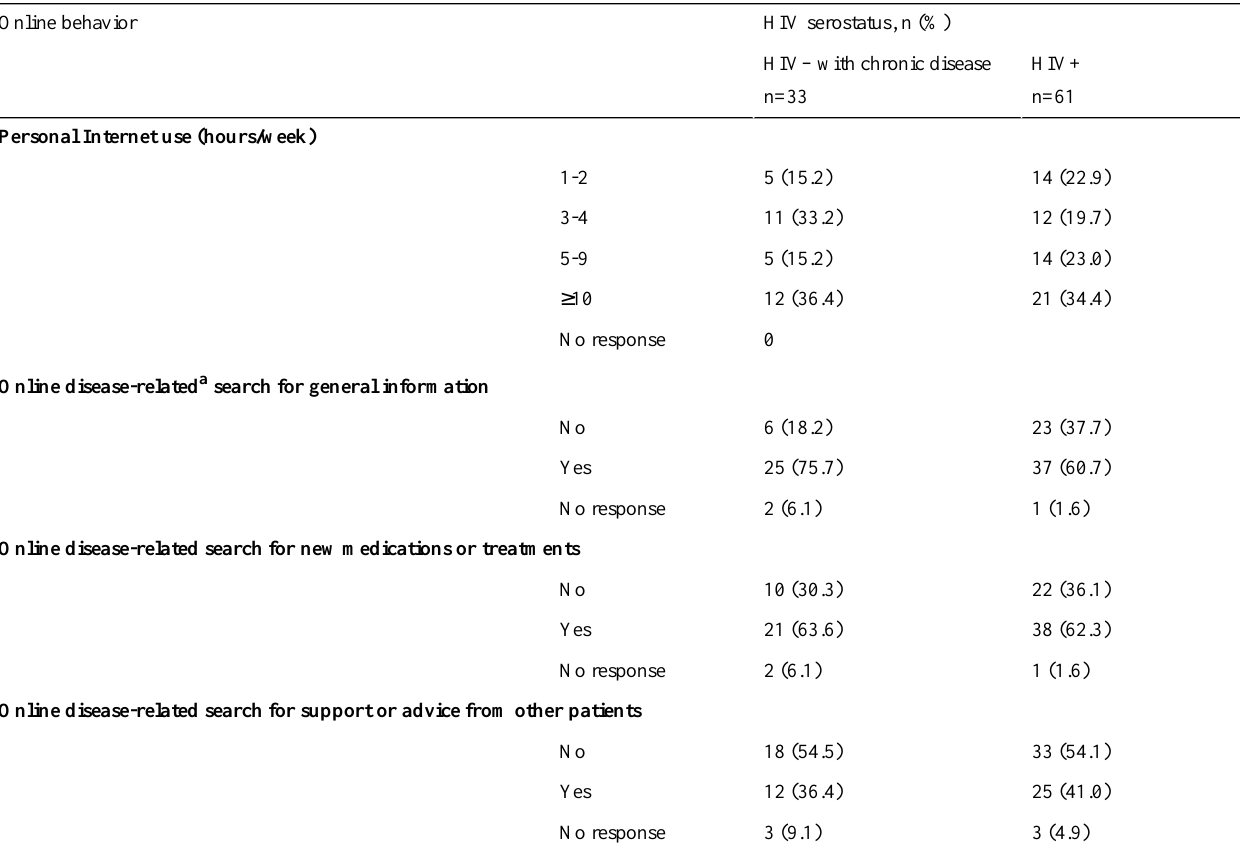
Table 2. Online behaviors of the HIV-seropositive participants compared to the HIV-seronegative participants with chronic disease.